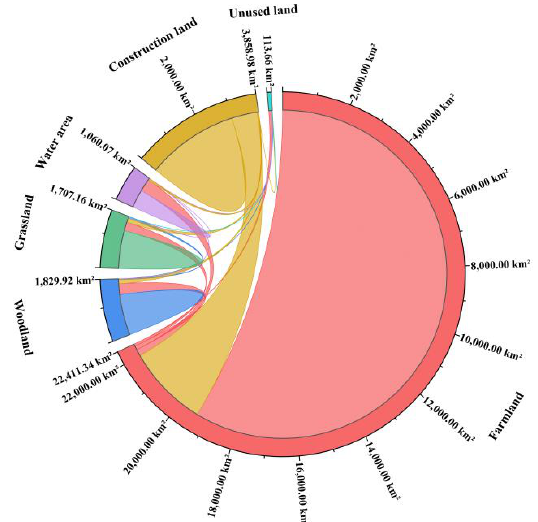
Figure 4. Land use change in Zhengzhou Metropolitan from 1980 to 2015.